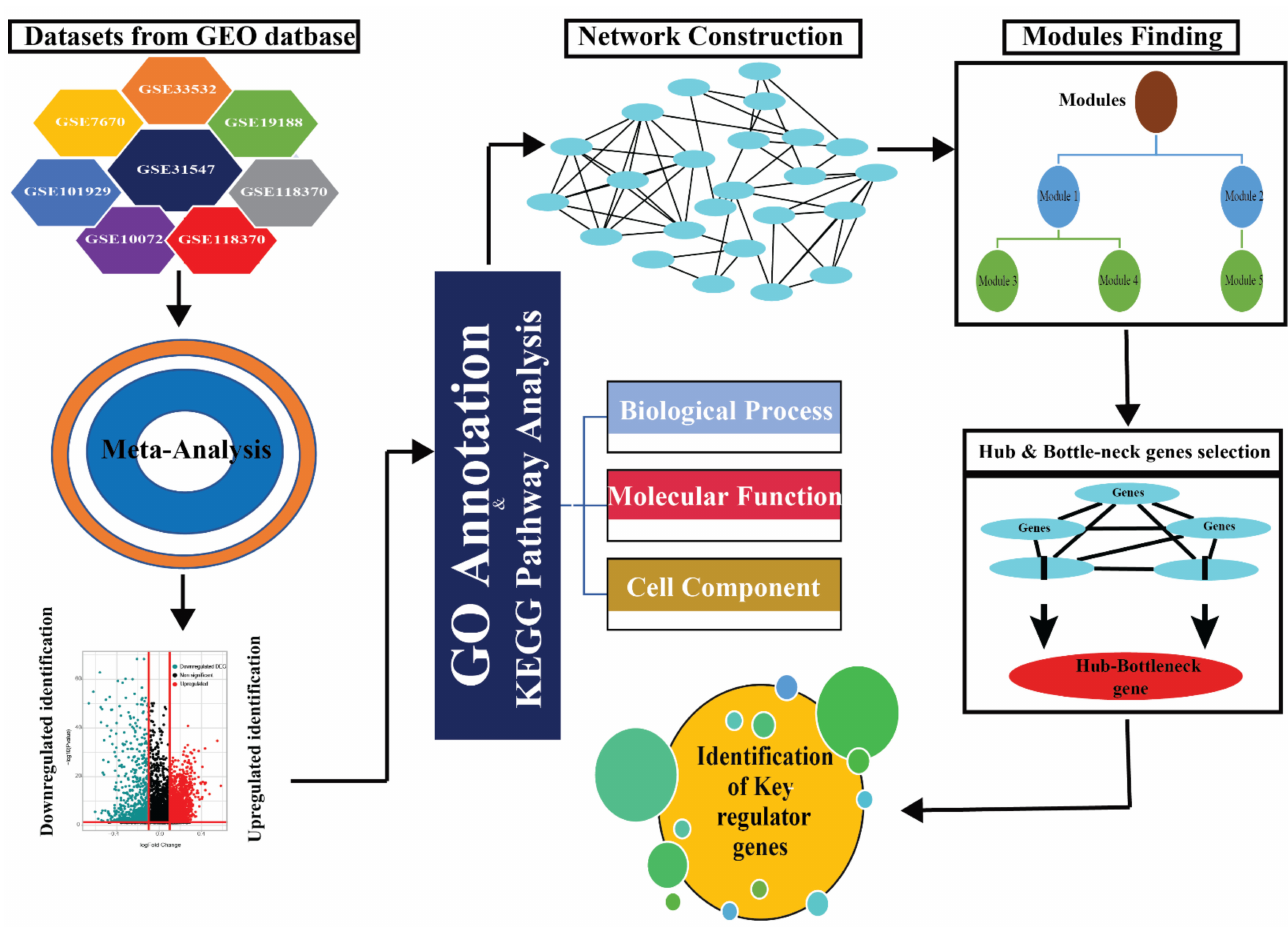
Figure 1. Systematic workflow of the